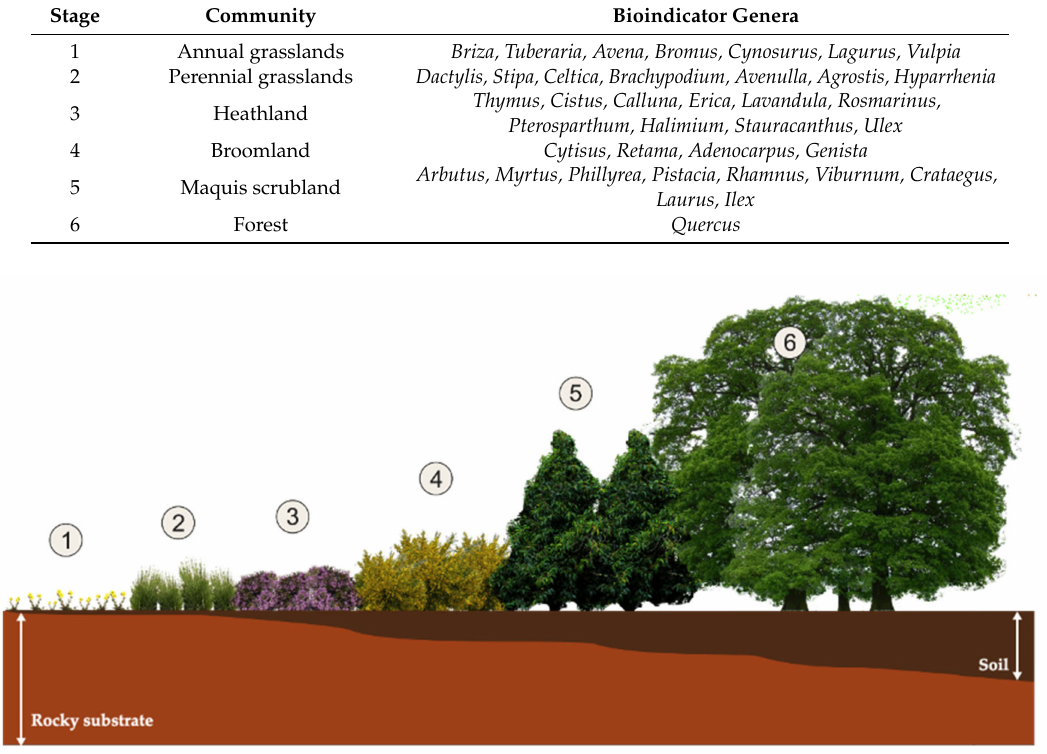
Figure 2. Dynamics of climatophilic vegetation in the Mediterranean: 1—annual grasslands;